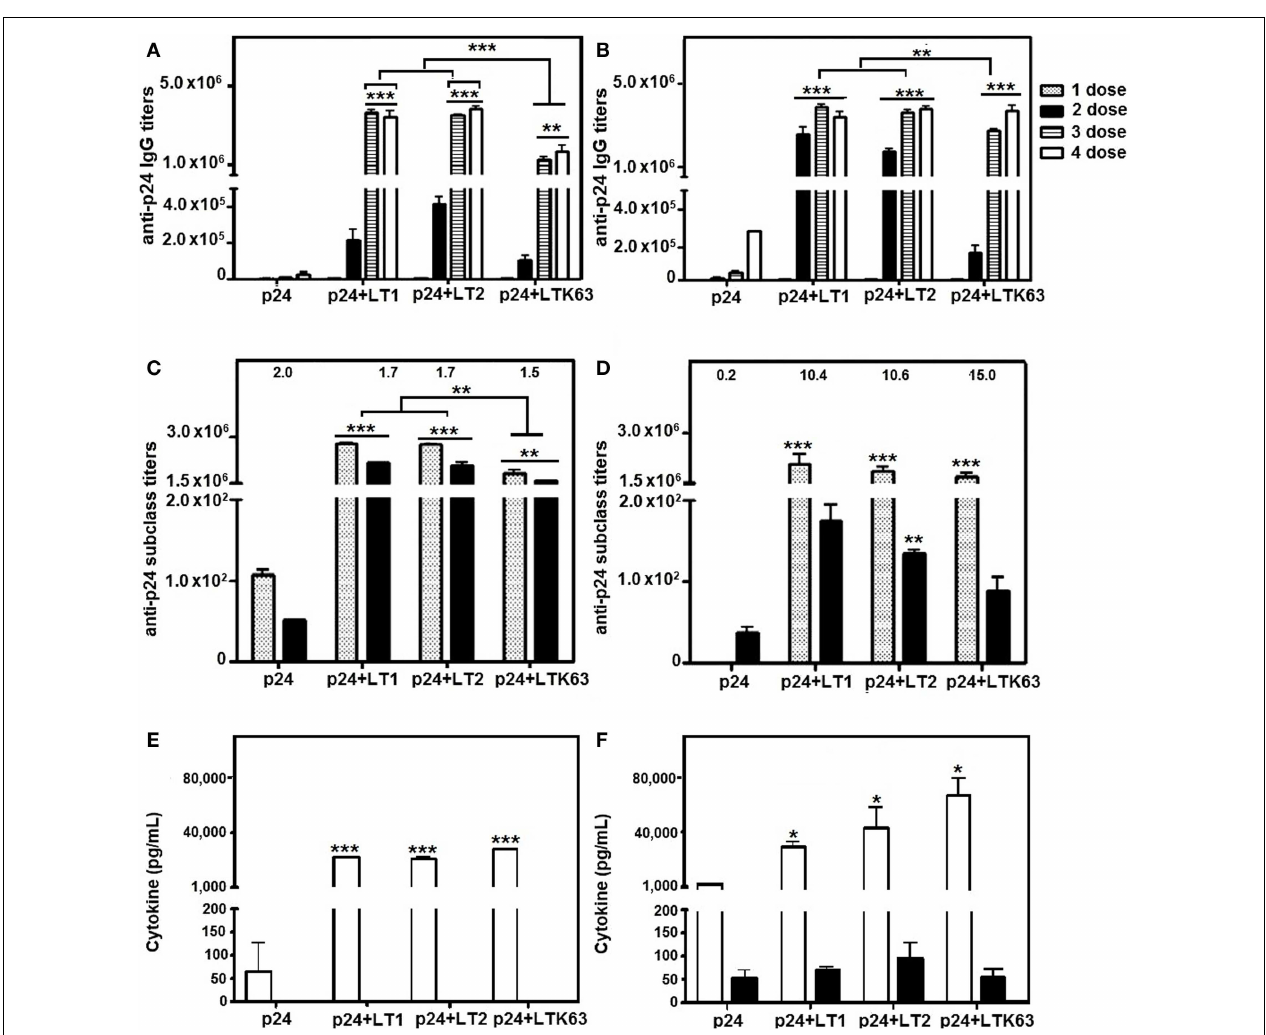
spleen cells collected from mice immunized via i.d. (E) or s.c. (F) routes 2weeks after the last immunization. Spleen cells were stimulated in vitro for 20h with a synthetic peptide (AMQMLKETINEEAAE) encompassing the immunodominant p24-specific MHC-II-restricted CD4 + T cell-specific epitope. Results are expressed as means ± SD ( n = 4–5 per immunization group) of three (A–D) or two (E,F) experiments performed independently.